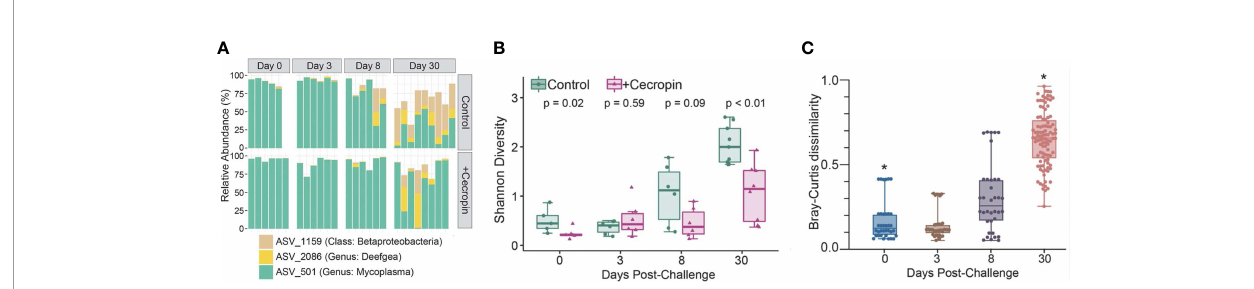
FIGURE 3 | Microbiome comparison between mock-challenged fi sh fed either control or +cecropin diet. (A, B) Relative abundance of the core ASVs shifted over time. Microbiomes started out dominated by a single species of Mycoplasma . Alpha diversity increased in both diet groups over time, though by day 30 alpha diversity was signi fi cantly higher in fi sh fed the control diet. (C) Individual microbiomes of fi sh fed the control diet were compared to microbiomes of fi sh fed the +cecropin for each time point. Each point on the graph represents a pairwise Bray-Curtis distance between individual microbiomes from the two diet groups. Lower distance values represent more similar microbiomes, while higher distances represent more divergent microbiomes. Statistical signi fi cance was evaluated by PERMANOVA, initially for all timepoints and both diets, and then for post-hoc pairwise comparisons between diets for each timepoint. Statistical signi fi cance on the graph refers to the difference between diet groups for an individual timepoint, where q is the p-value after correction for multiple comparisons